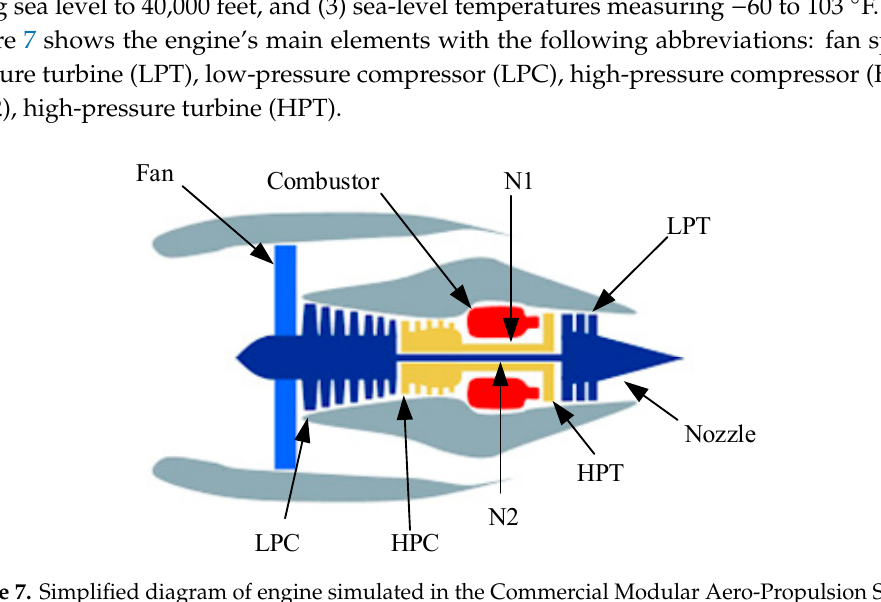
Table 1. C-MAPSS Data Overview.